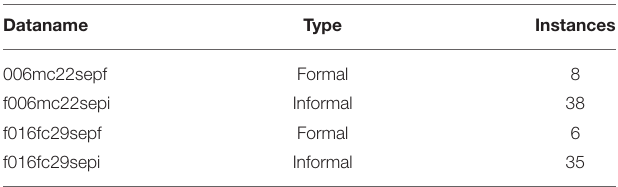
TABLE 3 | Resulting table of the second query showing the distribution of the pattern’s locations.